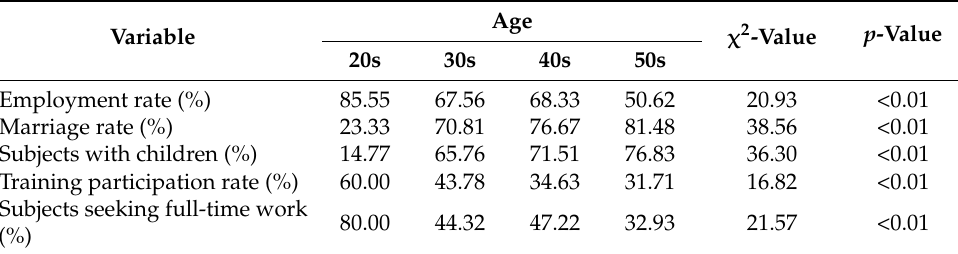
Table 1. Demographic results by